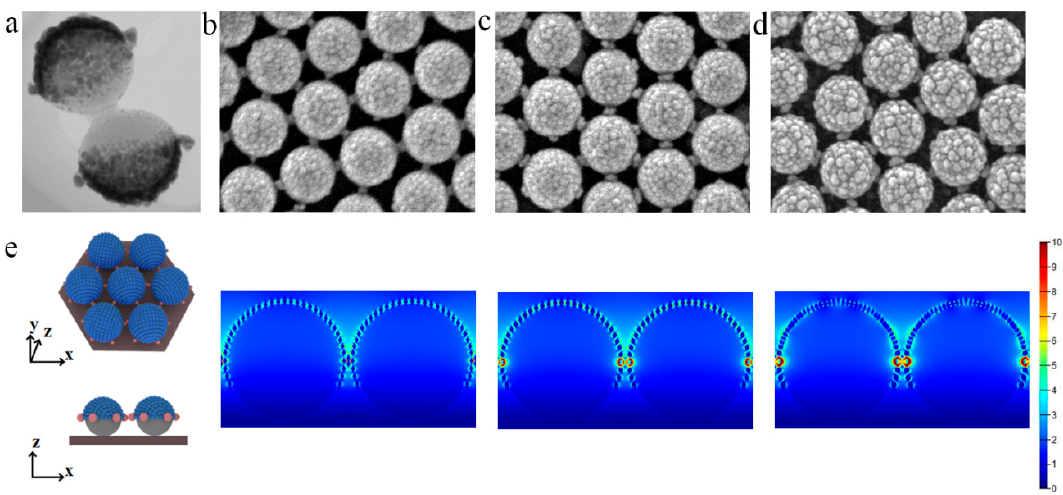
Figure 4. ( a – d ) TEM and SEM images of the SiO 2 − Ag film co-sputtered (5, 15, and 20 min) onto PS colloid sphere array after being etched for 60 s. ( e ) The idealized morphology and simulation results of SiO 2 − Ag nanocaps in the FDTD. Reproduced from [39] with permission from Elsevier, 2020.